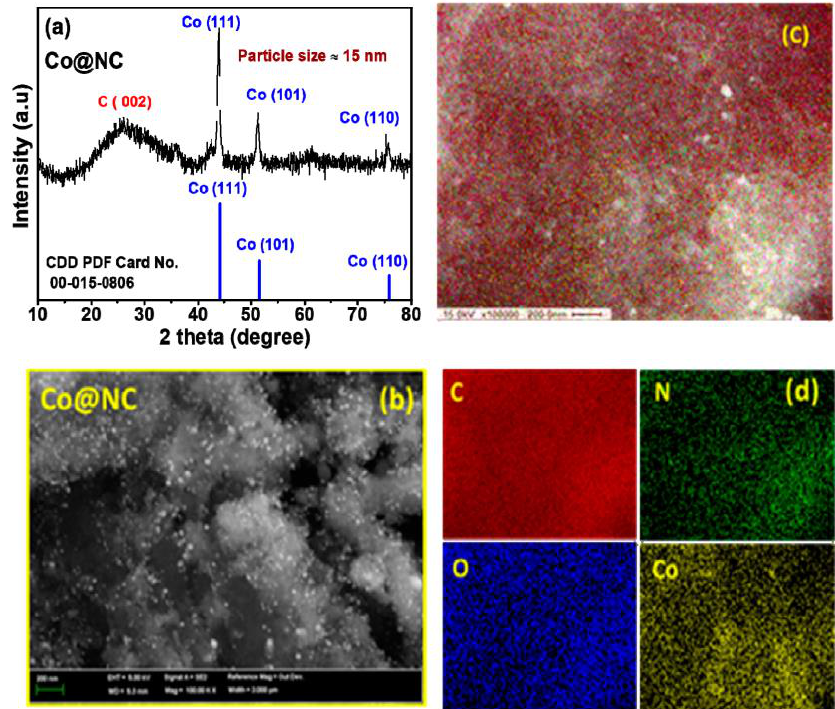
Figure 2. ( a ) X-ray diffraction patterns of Co@NC catalyst. ( b ) SEM images of Co@NC catalysts. Corresponding quantitative energy dispersive X-ray spectroscopy (EDS) elemental mapping of C, O, N and Co ( c ) combined map ( d ) individual mapping of elements.